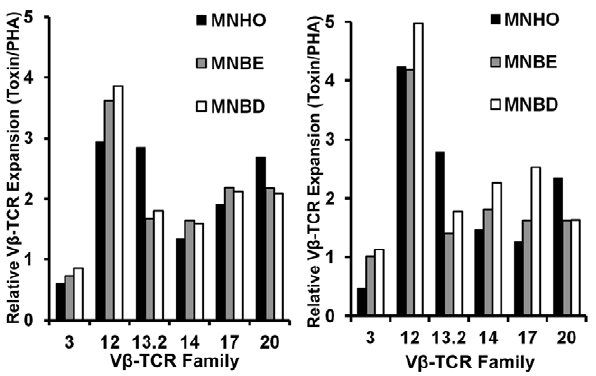
Figure 6. There is diversity in the profile of T-cell receptors that are bound by variant SEBs. We compared the V b -TCR expansion in PHA stimulated and SEB variants stimulated PBMC. In all, 24 V b -TCRs were analyzed. APC conjugated CD3 + blastogenic cells were gated on and simultaneous analysis of 3 V b -TCRs per tube was performed. The results are expressed as ratios of the V b -TCR expansion induced by SEB from MNHO or SEB from its variants relative to that by PHA with respect to the same individual. Data are shown from two different donor samples. V b -TCRs showing a . 1 fold increase in ratio of SEB/PHA were considered